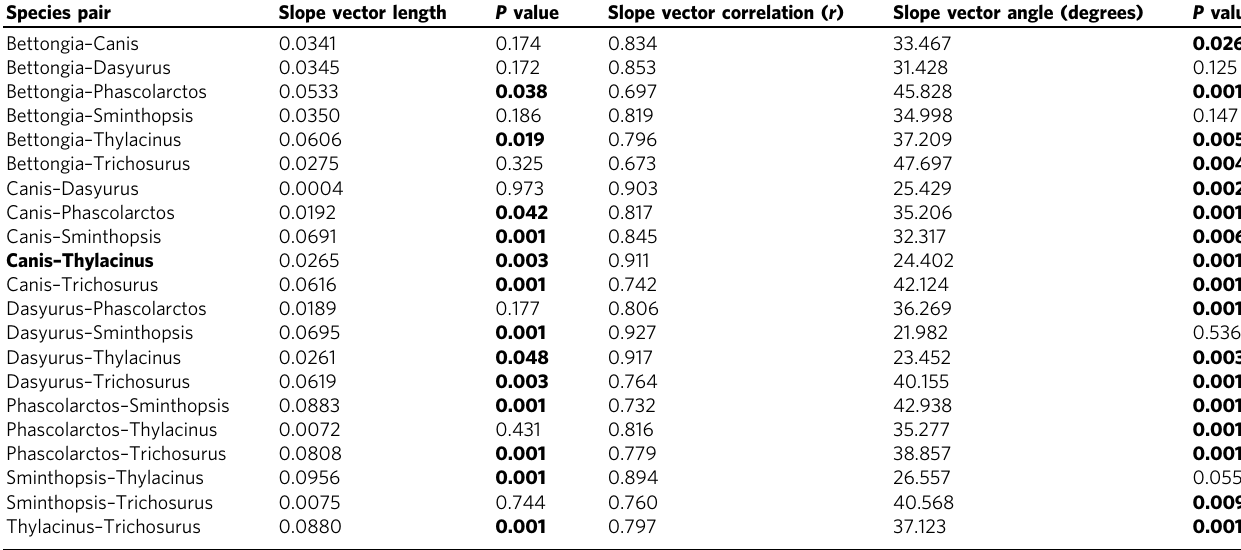
Table 1 Ontogenetic allometry — differences in slope vector length and angle between sampled species pairs. Species pair Slope vector